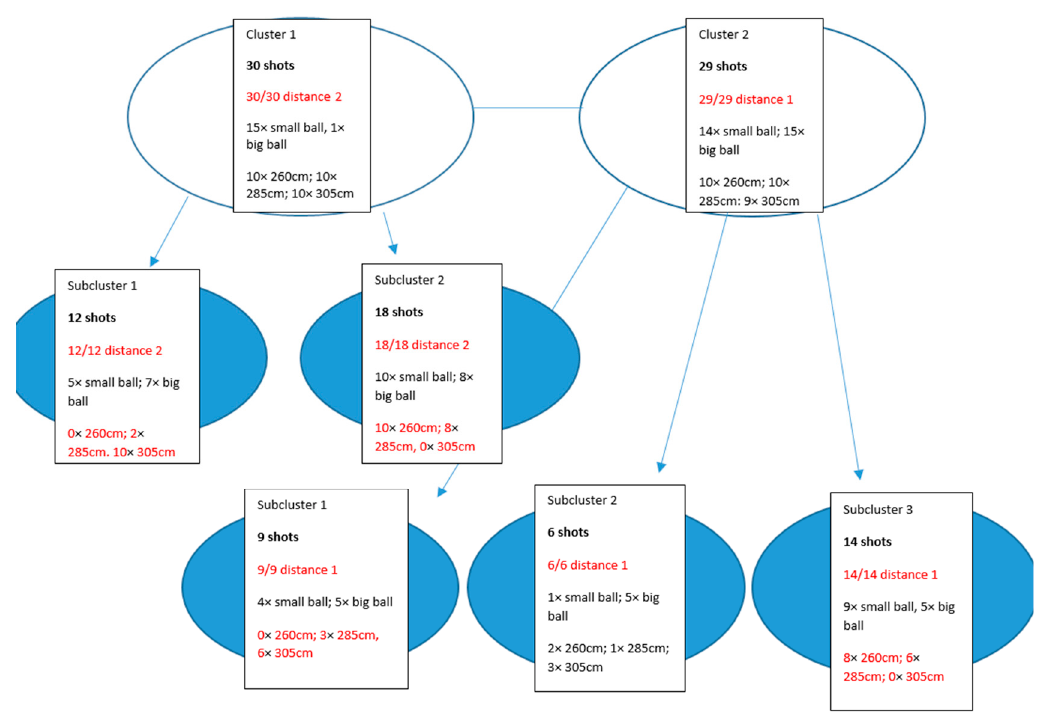
5 Figure 3. Dendrogram of subject 1, with distances highlighted in colors (Dis 1 = small distance; Dis 2 = far distance/free throw line). Ball sizes are indicated by their number (size 4 = small ball size; size 5 = big ball size); basket heights are labeled in cm (260/285/305).